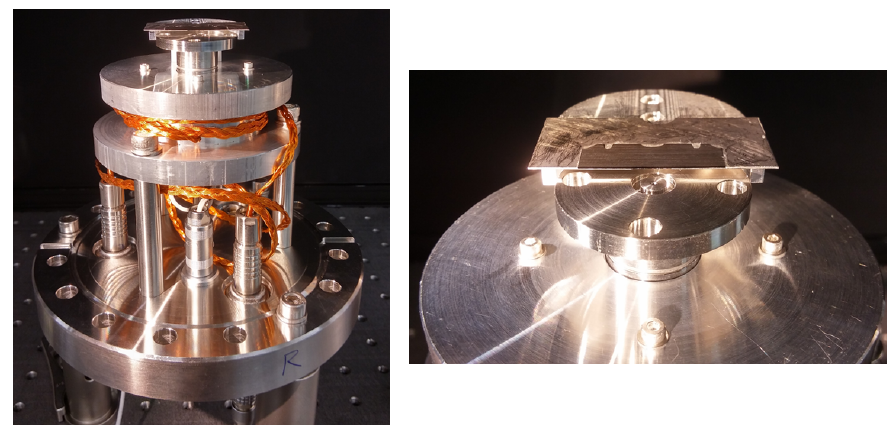
Figure 7. Tomography setup for shock front studies. A razor blade is positioned with a linear and a rotational